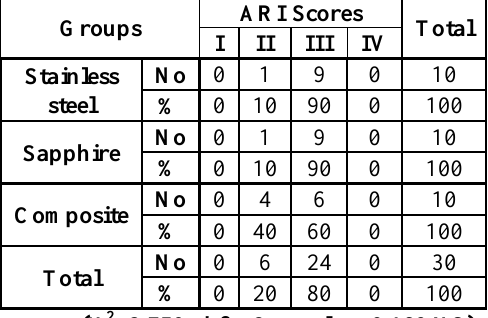
Table2: Frequency and distribution of the ARI scores in different